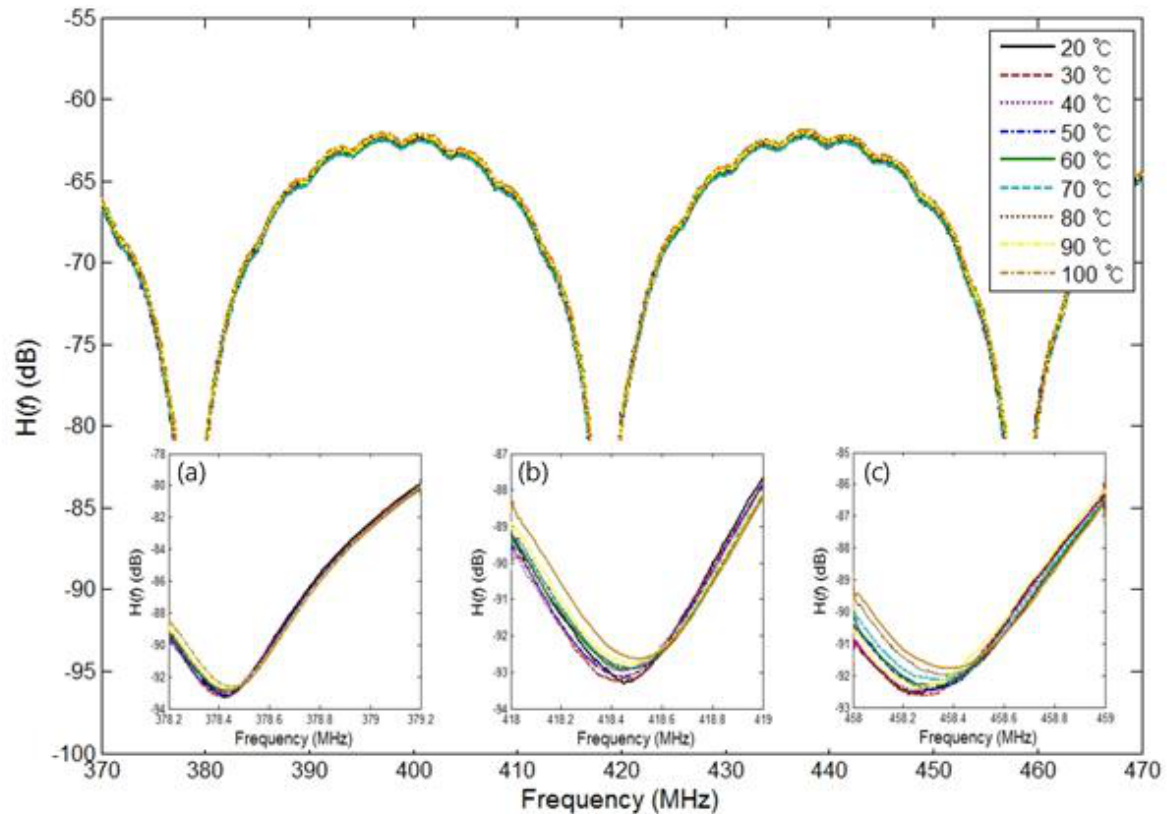
Figure 6. Measured transfer function H ( f ) for nine temperatures (from 20 °C to 100 °C in 10 °C steps) with 2.562 m in the frequency range of 370 MHz to 470 MHz, ( a ) H ( f ) in the frequency range of 378.2 MHz to 379.2 MHz; ( b ) H ( f ) in the frequency range of 418.0 MHz to 419.0 MHz; ( c ) H ( f ) in the frequency range of 458.0 MHz to 459.0